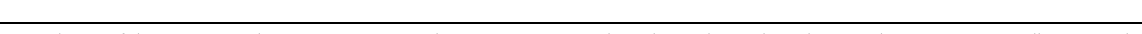
Fig. 2 Deletion of downstream sub-TAD compromises hA20 expression and results in elevated cytokine production. Primary cells were isolated from BAC transgenic mA20-de fi cient mice. a , b qPCR analysis of hA20 mRNA in transgenic primary cells. Primary B and T cells were isolated from spleens, macrophages cultured from bone marrow (BMDM), and synovial fi broblasts (SFs) were isolated from ankle joints. B cells were stimulated with antibodies against CD40 (2 μ g ml − 1 ) and IgM (5 μ g ml − 1 ), T cells with anti-CD3/anti-CD28-coated beads (1:1 cell to bead ratio), BMDM with LPS (25 ng ml − 1 ), and SF with TNF (20 ng ml − 1 ) for the indicated times. Data are combined from three independent experiments. Error bars indicate mean ± s.e.m., statistical signi fi cance was determined using one-way ANOVA followed by Tukey ’ s multiple comparison test. * P < 0.05; ** P < 0.01; *** P < 0.001. c Immunoblot analysis of hA20 protein in primary cells from transgenic mice. Primary cells were obtained and stimulated as in b . Data are representative of two to three experiments. d qPCR analysis of cytokine mRNA from ex vivo-stimulated cells. Data are combined from two independent experiments. Error bars indicate mean ± s.e.m., statistical signi fi cance was determined using one-way ANOVA followed by Tukey ’ s multiple comparison test, * P < 0.05. e Luminex analysis of CXCL10 protein in serum of transgenic and control mice. Data from three individual mice are shown. Error bars indicate mean ± s.e.m., statistical signi fi cance was determined using one-way ANOVA followed by Tukey ’ s multiple comparison test, * P <